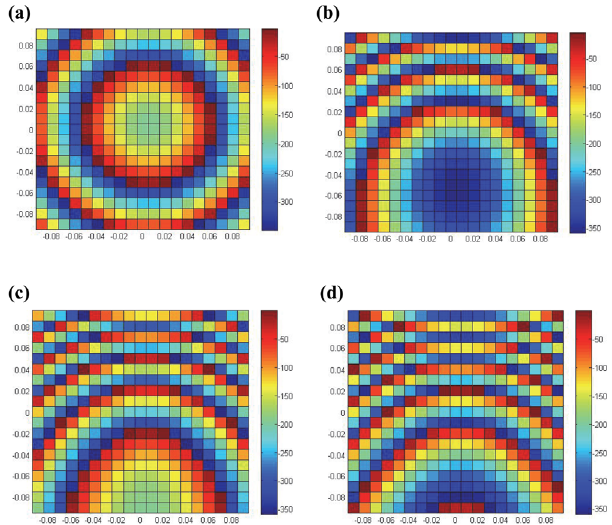
Fig. 7. The phase distribution diagram of main beam direction at (a) u =0 ° , f = 0 ° , (b) u = 30 ° , f = 0 ° , (c) u =45 ° , f =0 ° , and (d) u =60 ° , f = 0 ° , respectively.